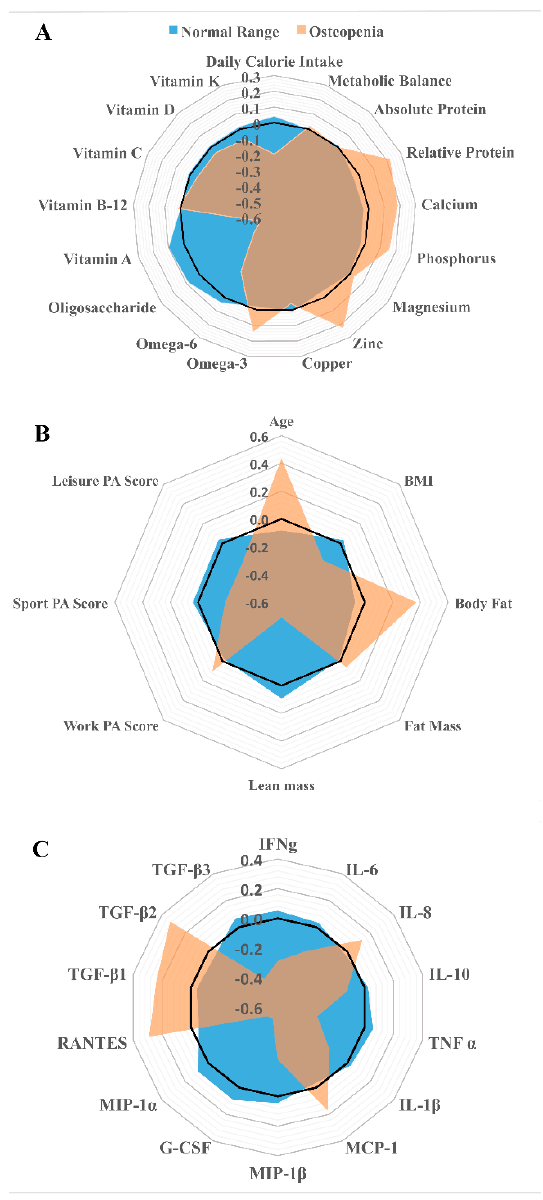
Figure 2. Comparison of the patterns of nutrient z-scores ( A ) associated with bone health [4] taken from the participants’ habitual diet, characteristics ( B ) and endocrine levels ( C ) and categorized by their T-score computed from reference data from the national health and nutrition examination database (normal range vs. osteopenia T- score < − 1.0).